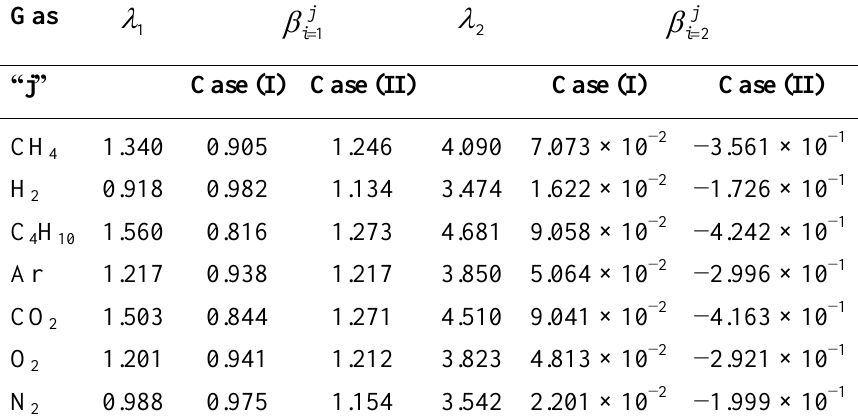
ß , for Equation (6) for cell III ( 1/  VLA ). i